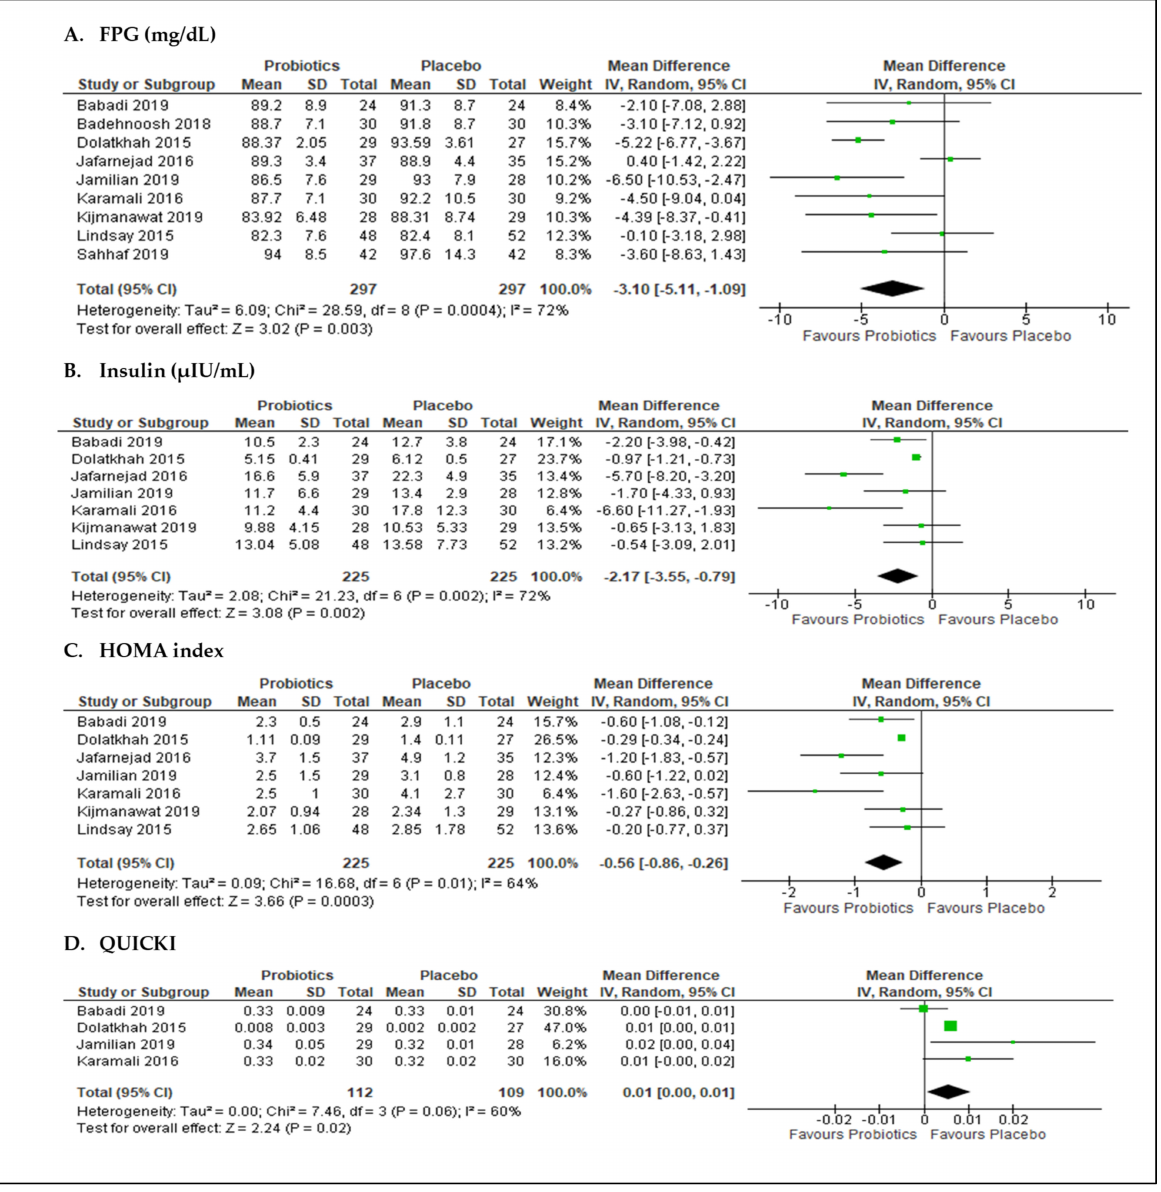
Figure 3. Meta-analysis of probiotics versus placebo on glycemic outcomes: ( A ) FPG, fasting plasma glucose; ( B ) insulin, ( C ) HOMA, homeostasis model assessment index; and ( D ) QUICKI, quantitative insulin sensitivity check